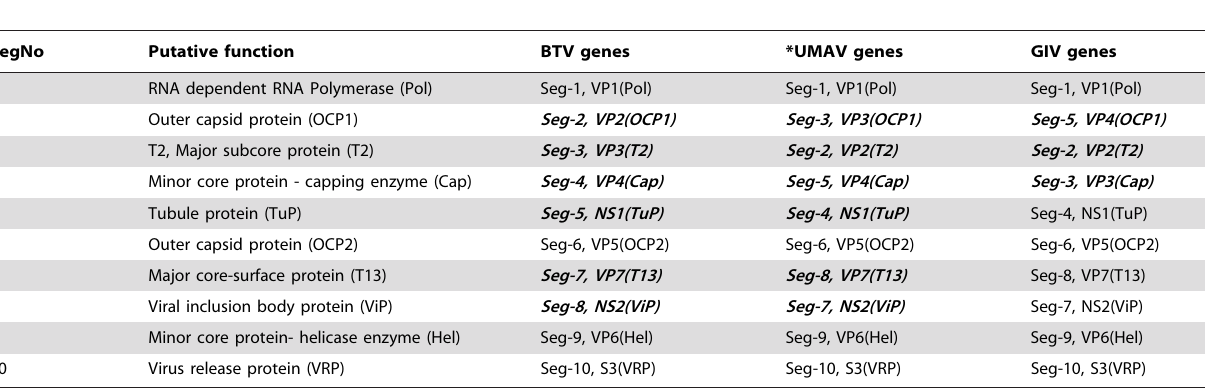
Table 2. Homologous proteins of BTV ( Culicoides borne), UMAV (mosquito borne) and GIV (tick-borne) orbiviruses.